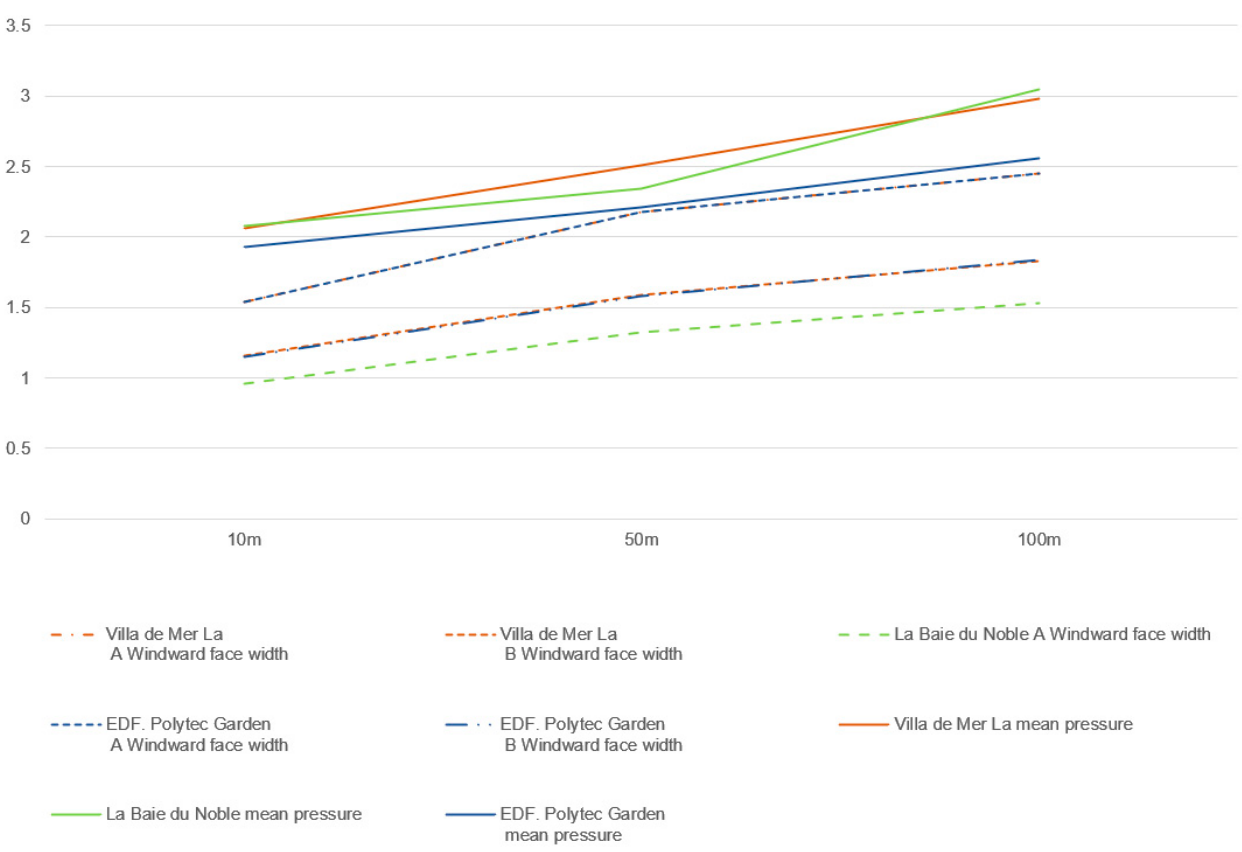
Figure A20. Comparison of windward parts of different residences with their average wind pres- sures.